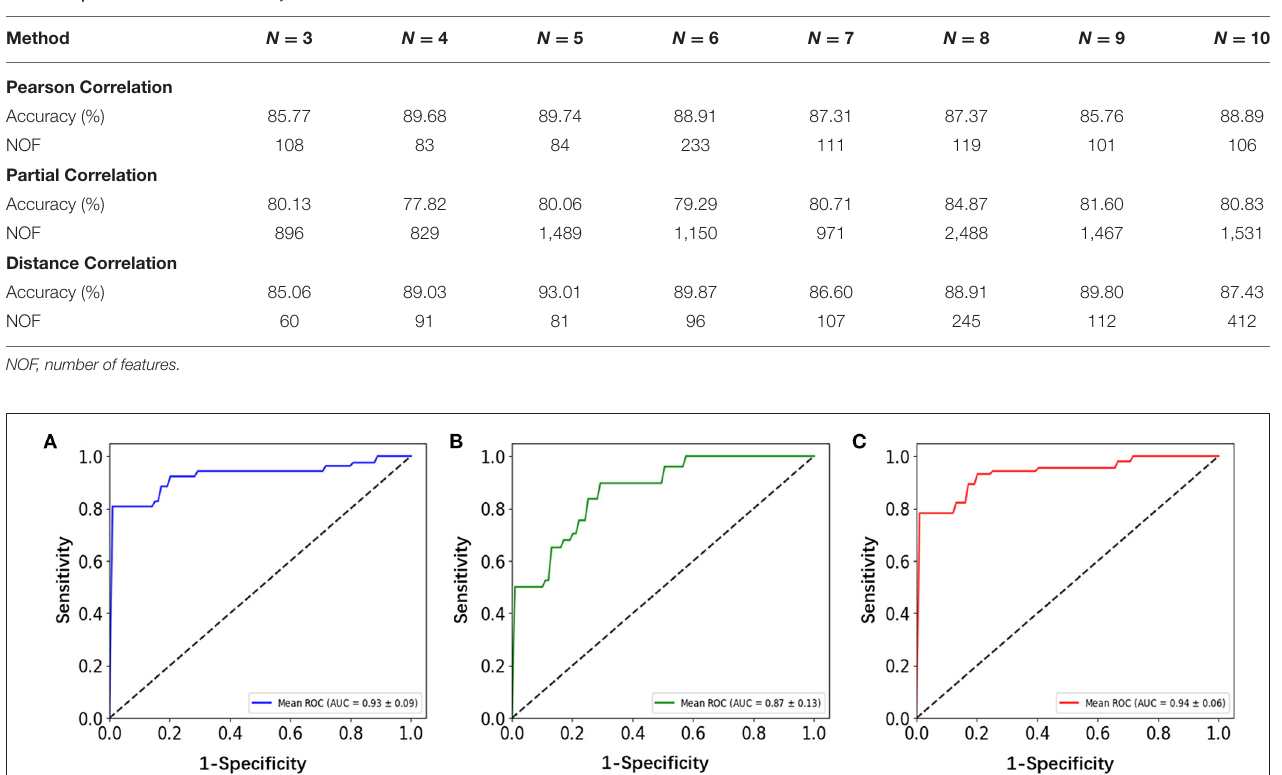
TABLE 2 | Results of classification by the different number of the features.